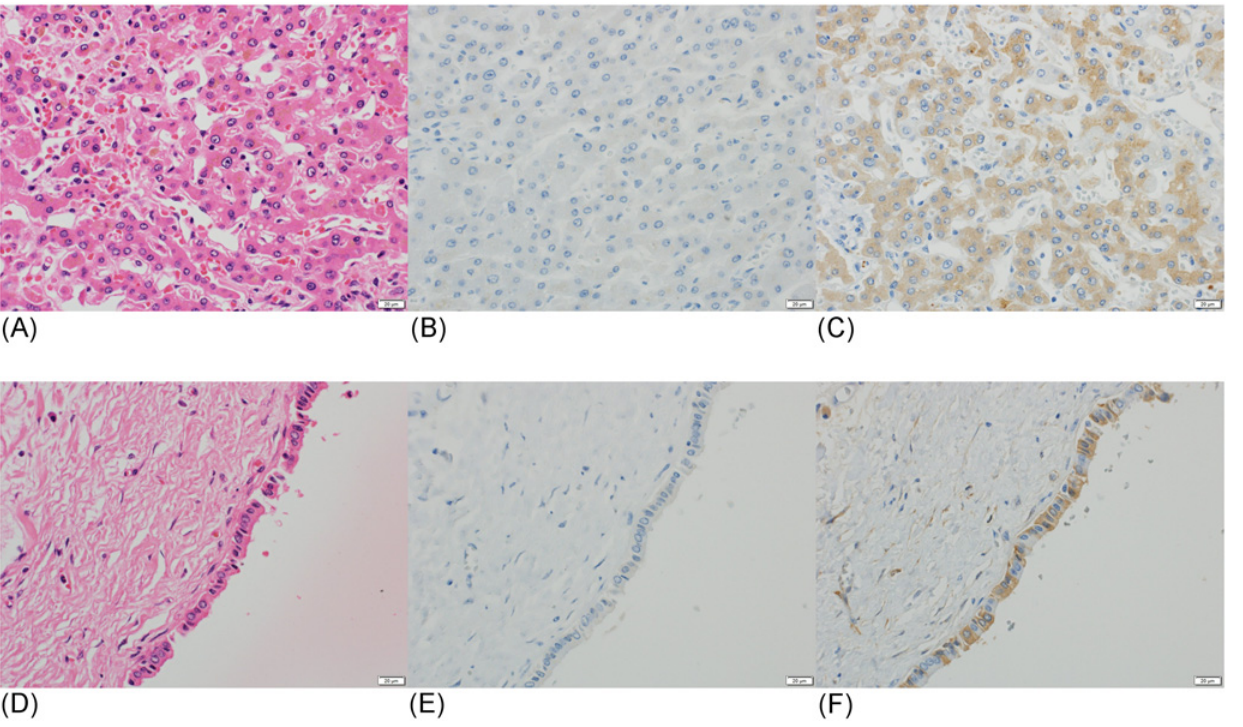
Fig 5. Immunostaining of DCP and NX-DCP in liver tissue of a patient with obstructive jaundice. (A-C) Liver tissue in a case of obstructive jaundice showing NX-DCP expression, but no DCP expression. HE stain (A), and immunostain for DCP (B) and NX-DCP (C). (D-F) Biliary epithelial cells of the same case showing NX-DCP expression, but no DCP expression. HE stain (D), and immunostain for DCP (E) and NX-DCP (F).